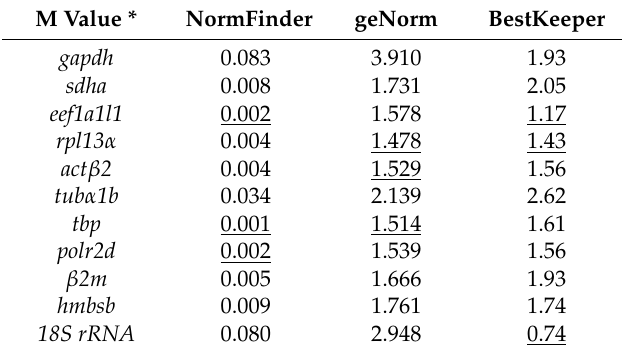
Table 3. Stability analysis of candidate reference genes in the zebrafish embryo mitoxantrone test before 96 hpf